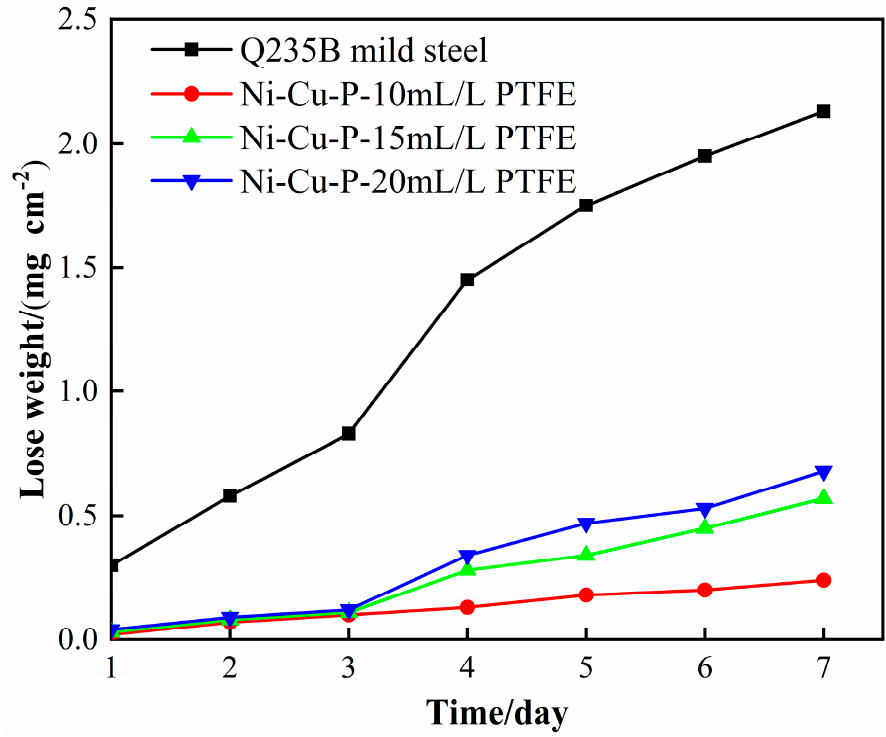
Figure 8. The corrosion rate of Q235B mild steel and Ni-Cu-P-PTFE composite coatings with different PTFE concentrations in 5 wt% NaCl solution.